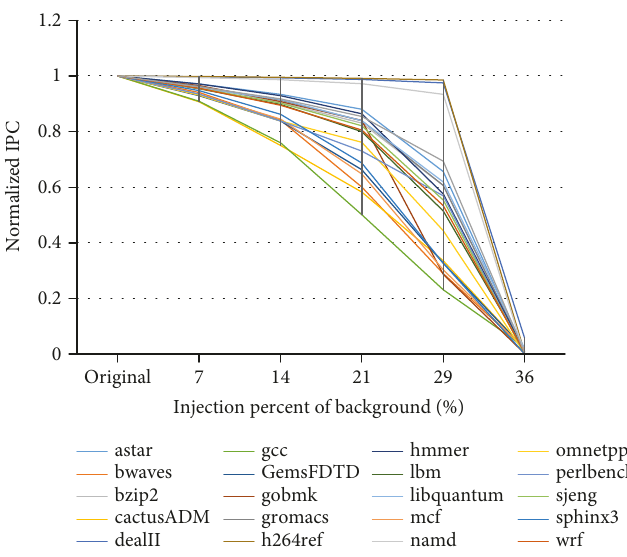
Figure 1: Instructions per cycle (IPC) status with a simulated network